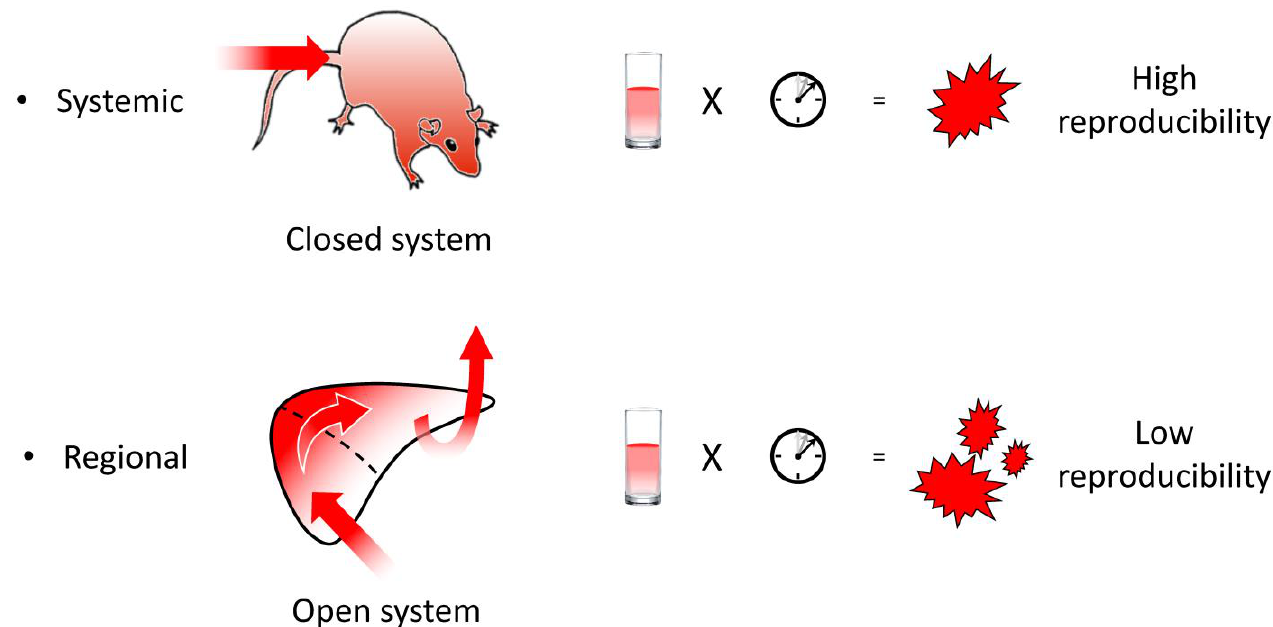
Figure 2. Establishment of hydrodynamic impacts in systemic and regional injections.